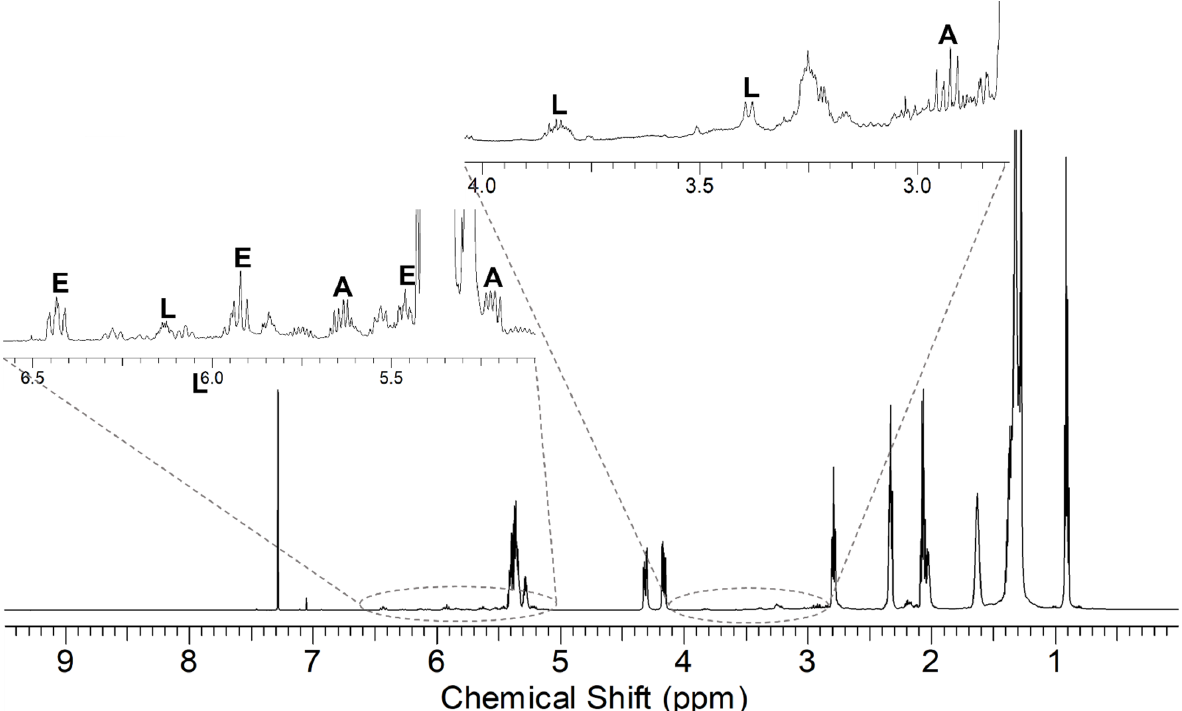
Figure 6. 1 H NMR of the sample GO2 MW; the signals of the main products refer to the compounds A , E (or F ), and L (or M ) of scheme 3, bearing the same groups reported in Figure 5.